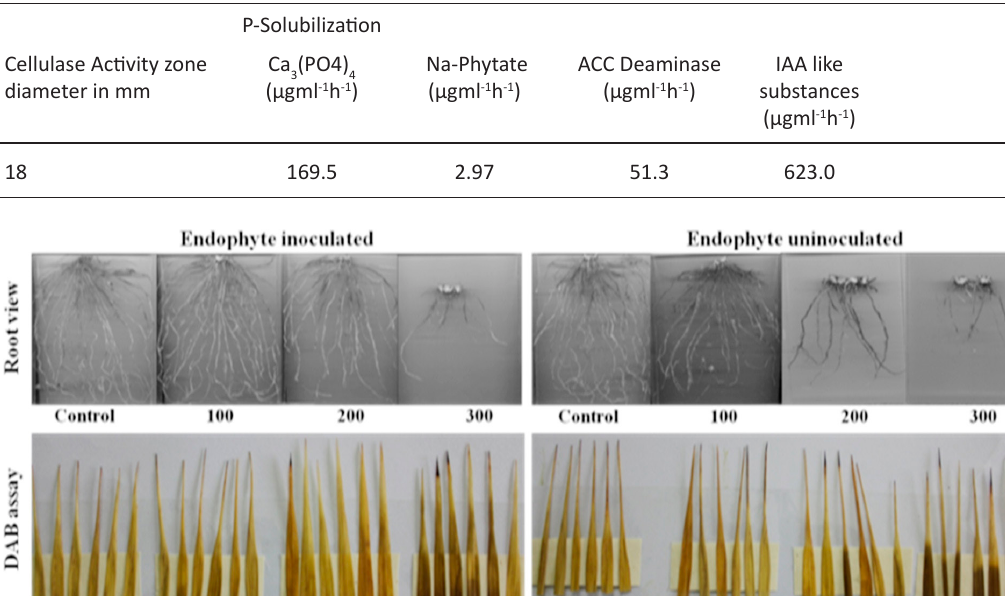
Table. 1 Plant growth promoting activities Serratia